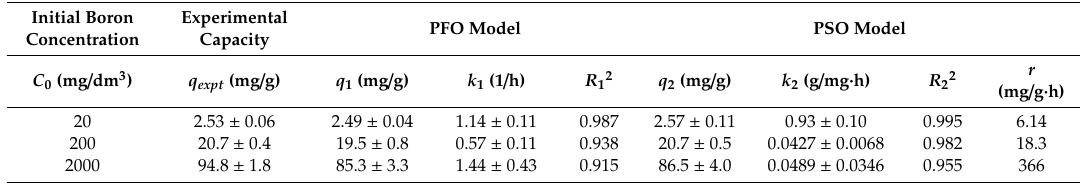
Table 1. Kinetic parameters for boron adsorption on La-CTS hydrogel beads at 20 ± 1 ◦